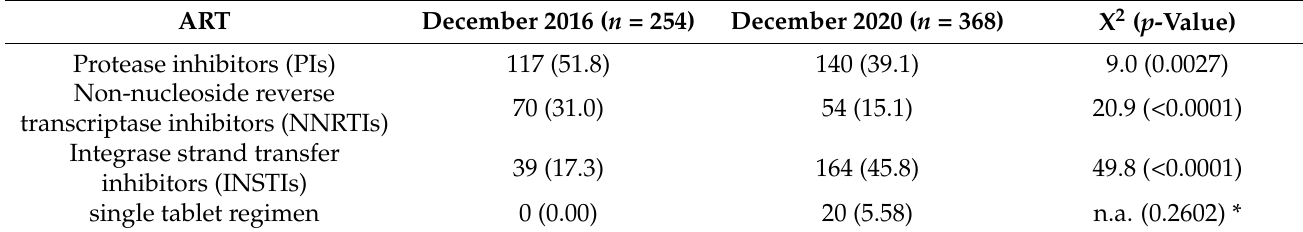
Table 3. Antiretroviral therapy